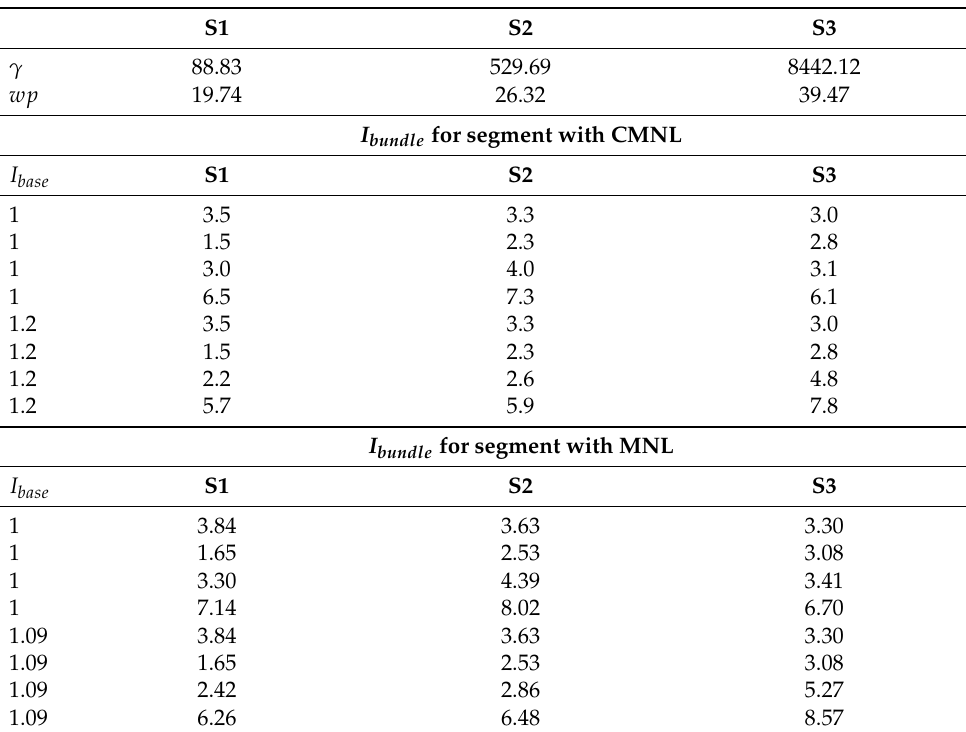
Table 10. γ , wp , bundles’ and base attractiveness.